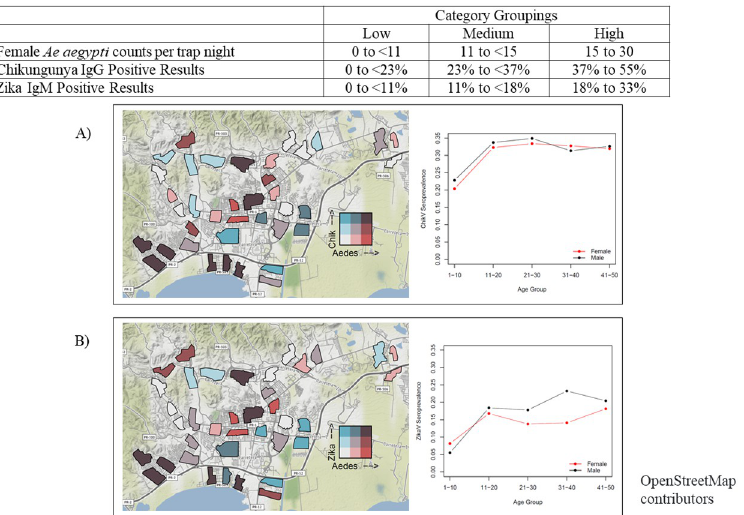
Fig 1. Chikungunya virus (A) and Zika virus (B) seroprevalence by age and sex with Ae . aegypti mosquito density by cluster. The map base layer was created using data from OpenStreetMap contributors, which is available under